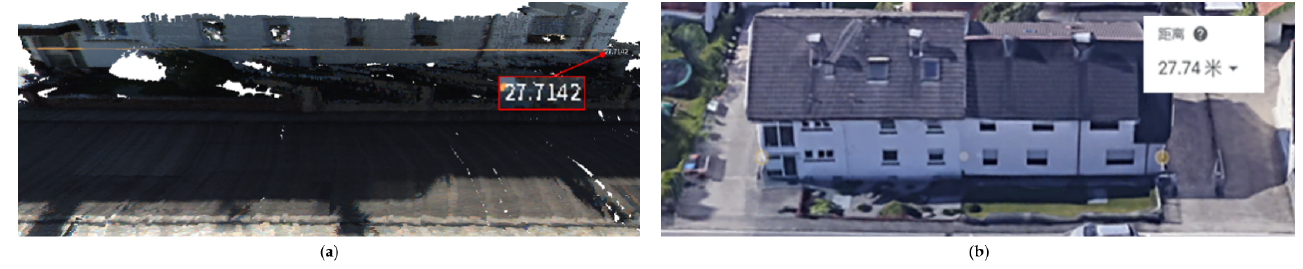
Figure 7. Width comparison between the reconstruction and the real building: ( a ) the length of the building measured using MeshLab is 27.7142 m. ( b ) The length of the building measured using GoogleEarth is 27.74 m.